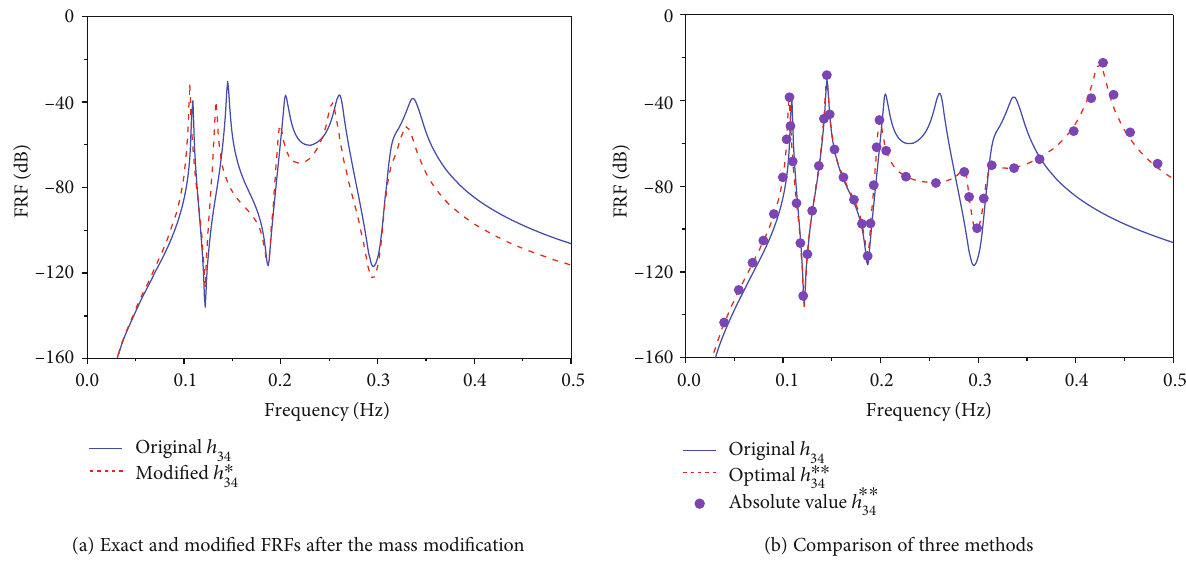
Figure 8: Comparison of FRFs between original and modi fi ed systems with modal damping ratio 0.84%.